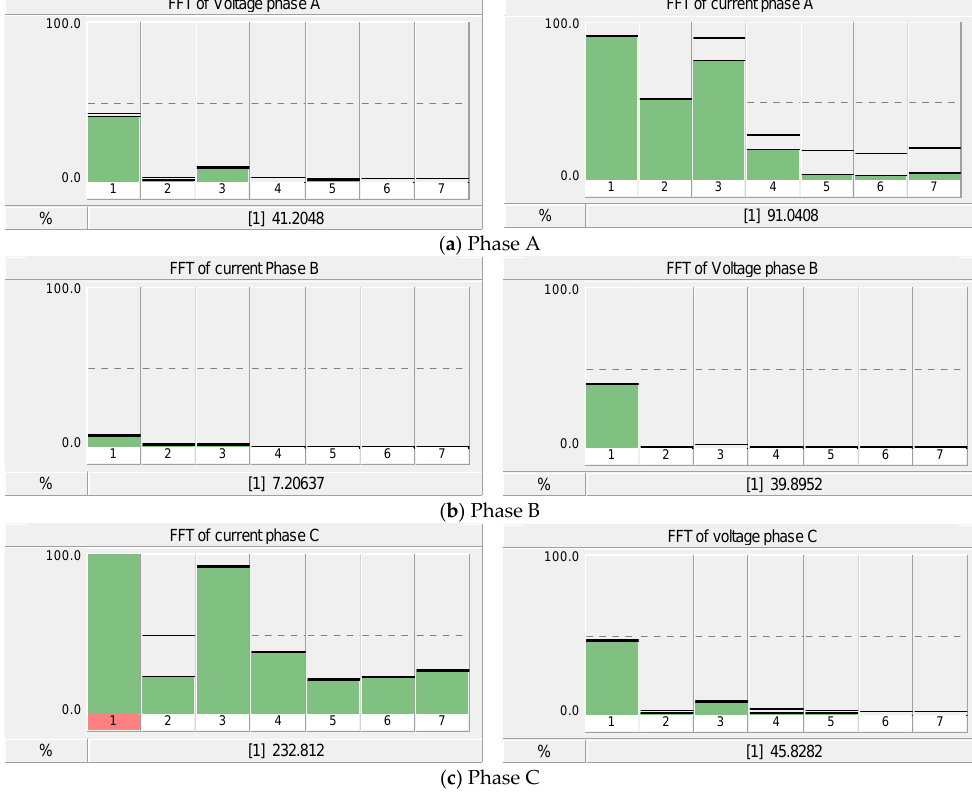
Figure 26. The frequency spectrums of the phase voltage and current at the LV side (0.4 kV) transformer 500 kVA when the BRKC close circuit is at 0.7 s.